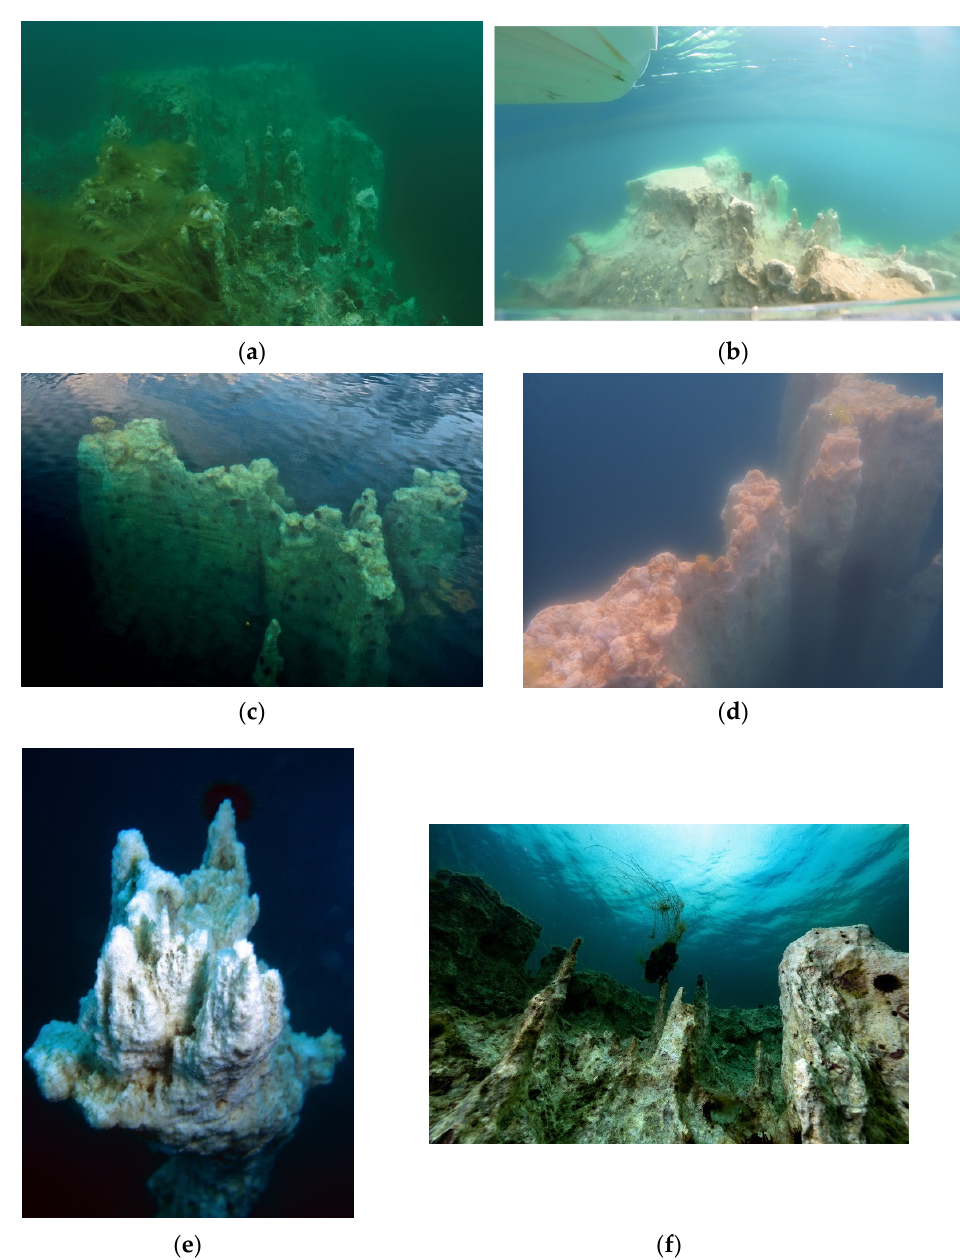
Figure 10. Comparison of the Atoll column in ( a ) summer of 1995 with ( b ) July 2022, ( c ) the Obelisk column row from the period 1995 – 97 compared to ( d ) the Obelisk in July 2022, ( e ) the tip of the columns as they were commonly observed in 1995 – 97 covered in fresh white ikaite powder, and ( f ) the side wall of the Atoll as it appeared in August 2021 yellowish and more porous surface. Photo credits: Richard Martin ( a ), ( c ), and ( e ), Paul Seaman ( b ), Bengt Liljebladh ( d ), and Florian Huber ( f ).